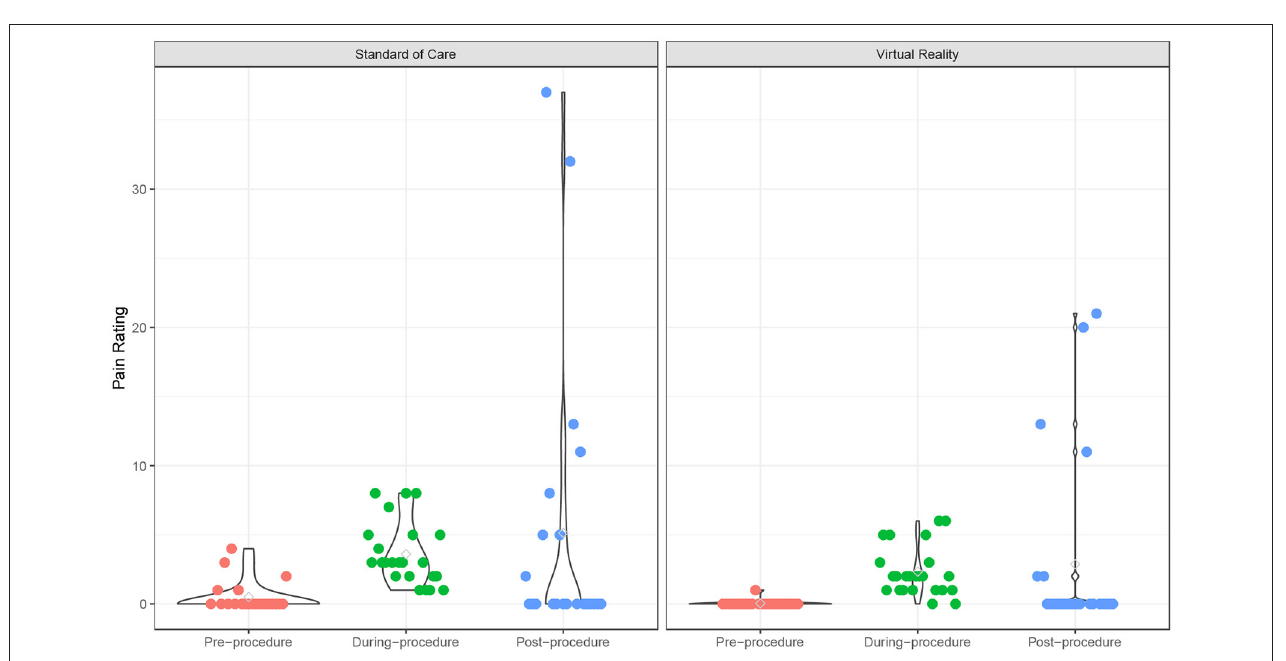
FIGURE 3 | Pain rating over time. Pain ratings of Virtual Reality (VR) and SOC groups as measured by the Pain scale.